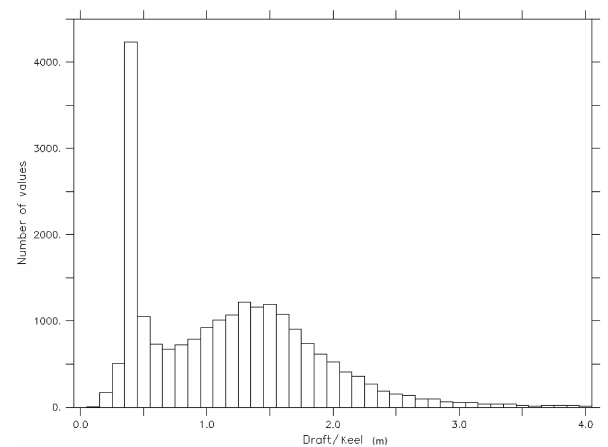
Figure 2. The histogram of the ULS measurement, 10 February 2007, for the estimation of draft and keel (metres).